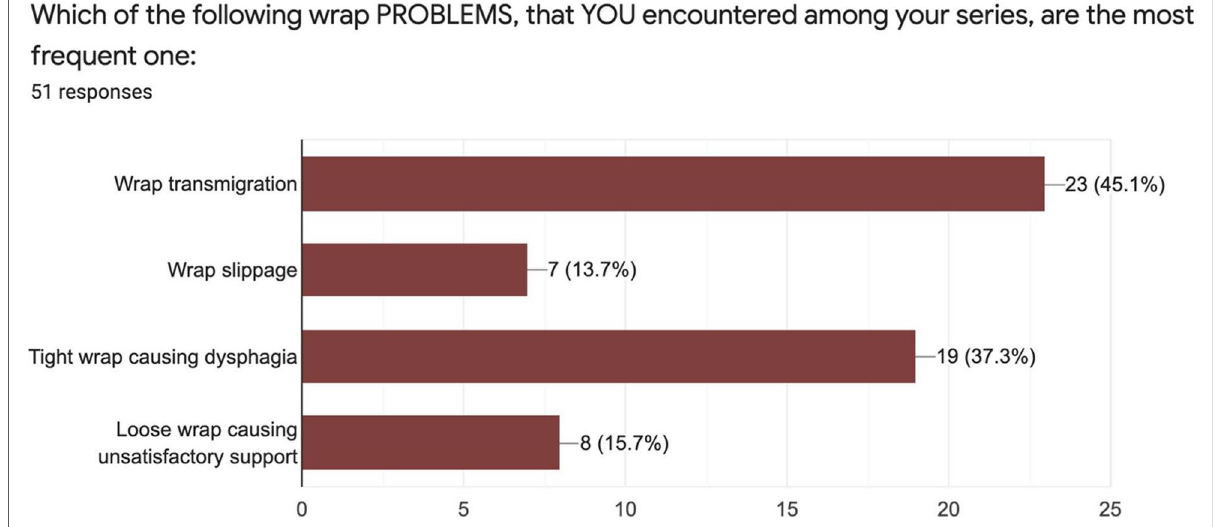
Fig. 1 Frequency of wrap-related troubles among the